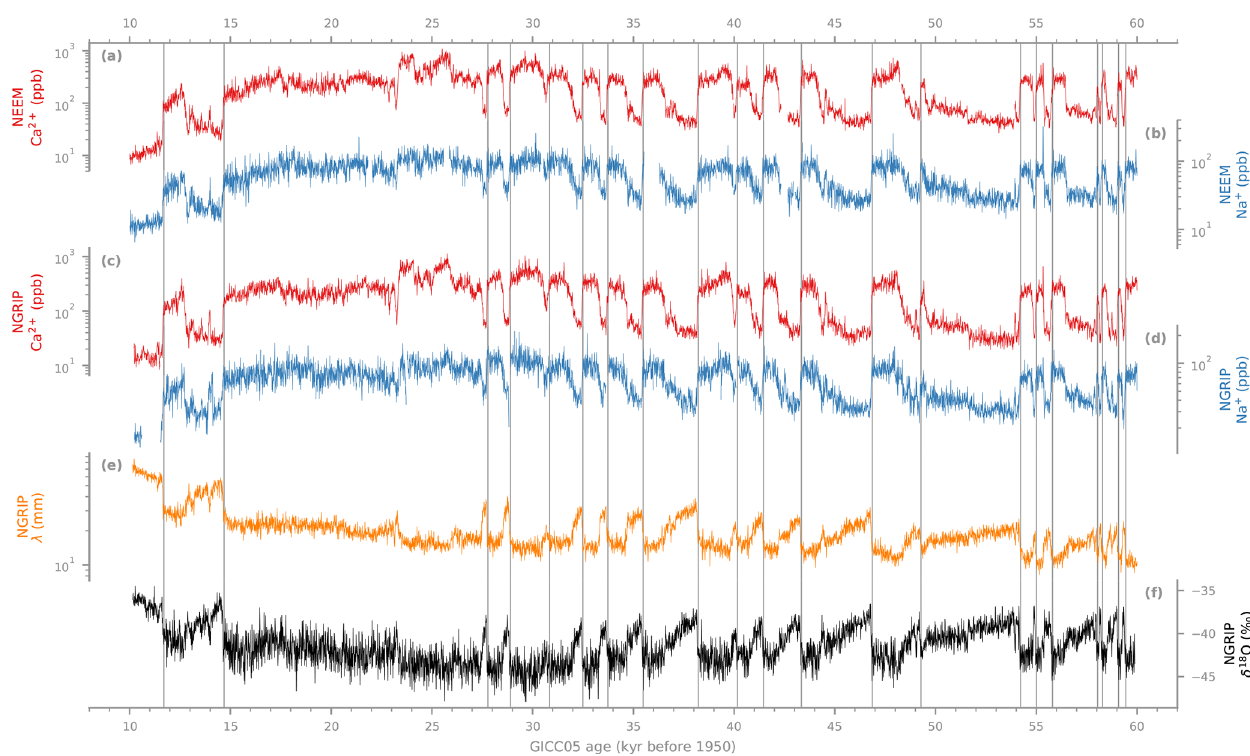
Figure 1. Investigated records from the NEEM (a, b) and NGRIP ice cores (c–f) . Panels (a) , (d) show the new aerosol records of Ca 2 + (a, c) and Na + (b, d) alongside the NGRIP layer thickness ( λ ) (e) and ice δ 18 O records (f) . All records are shown as decadal averages on their respective version of the GICC05 age scale relative to 1950 (Svensson et al., 2008; Rasmussen et al., 2013). The vertical lines mark the investigated interstadial onsets as given by Rasmussen et al. (2014). Note that the vertical scales for the aerosols and annual layer thickness are